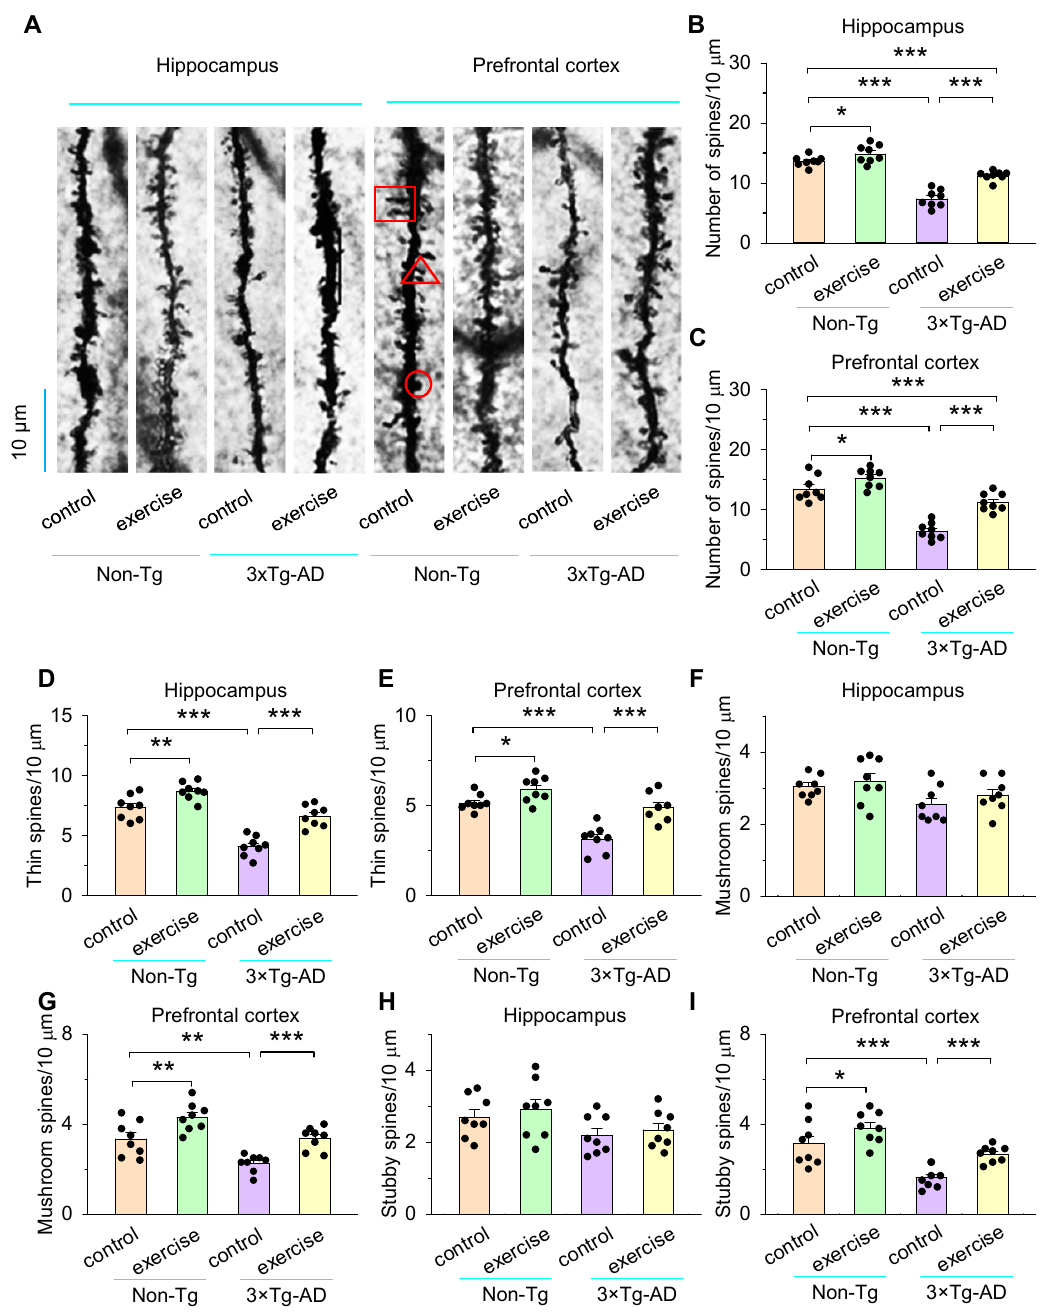
Figure 6. Treadmill exercise improves the dendritic spines numbers of hippocampus and prefrontal cortex in 3 × Tg-AD mice. ( A ) Representative Golgi staining images of the secondary dendrites of the CA1 pyramidal neurons in the hippocampus and layer V pyramidal neurons prefrontal cortex in non-Tg control, non-Tg exercise, 3 × Tg-AD control, and 3 × Tg-AD exercise mice. The dendritic spines in rectangles, triangles, and circles are thin, mushroom, and stubby dendritic spines, respectively. ( B , C ) The spines numbers of hippocampus ( B ) and prefrontal cortex ( C ) were significantly decreased in the 3 × Tg-AD control group compared to the non-Tg control group (*** p < 0.001, n = 8), and this decrease was blocked by treadmill exercise pretreatment both in the hippocampus ( B ) and prefrontal cortex ( C ) (*** p < 0.001, n = 8 dendrites, respectively). Treadmill exercise pretreatment increased the spines numbers of the hippocampus ( B ) and prefrontal cortex ( C ) in non-Tg mice (** p < 0.01, n =